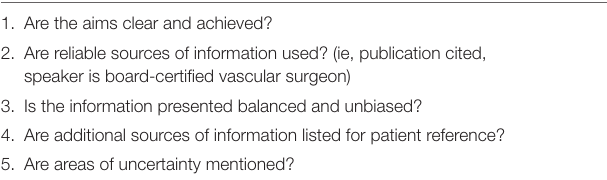
TABLE 2 | Modified DISCERN